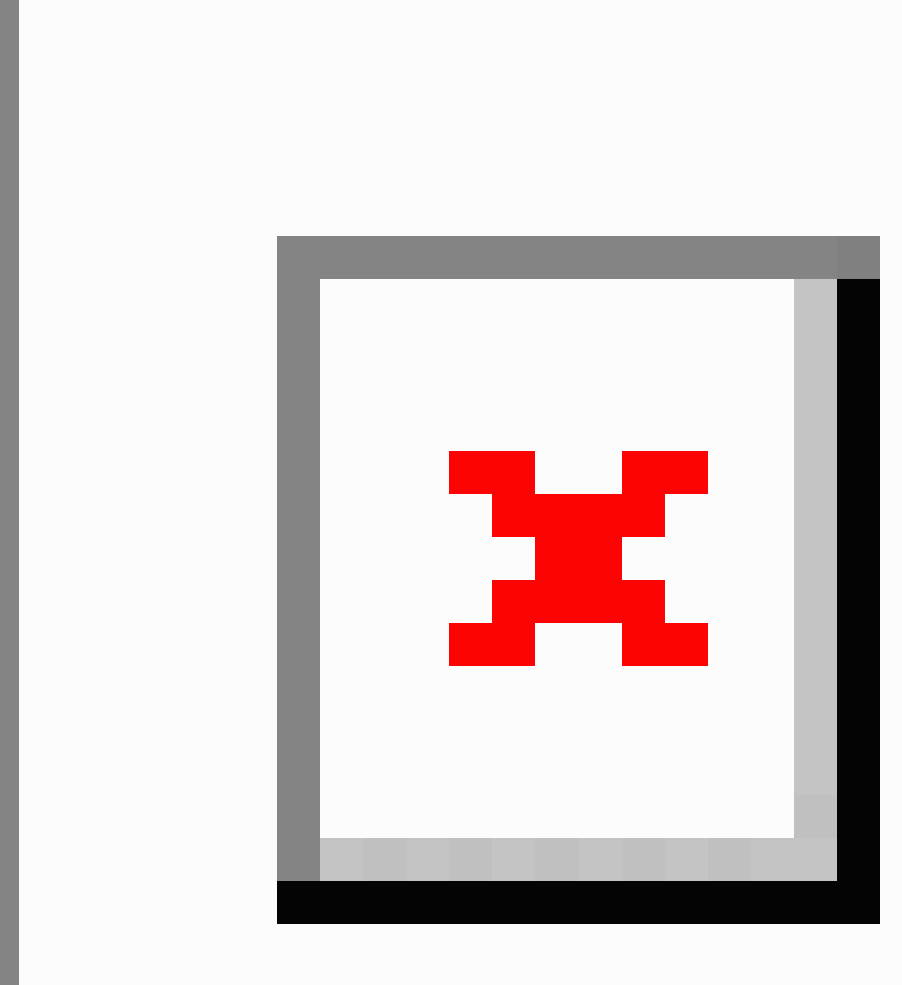
Figure 2. Physiotherapy Party